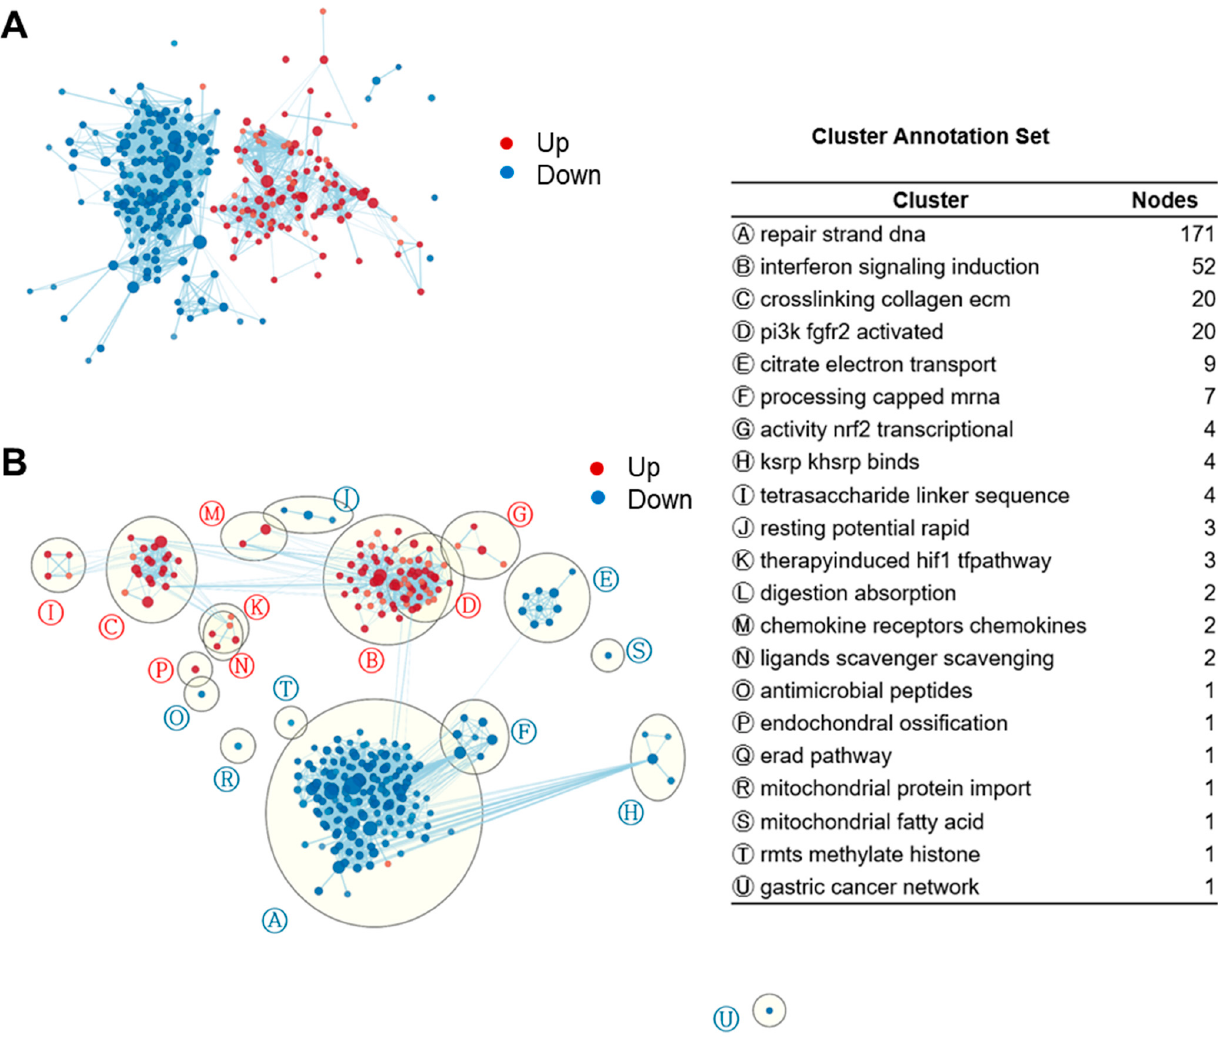
Figure 3. Enrichment maps of GSEA gene sets revealed strong induction of IFN signaling in fucoidan-treated BMDCs. ( A ) Unformatted GSEA gene sets enrichment map. Each node (circle) represents a distinct pathway, and edges (lines) represent the number of genes overlapping between two pathways, determined using the similarity coefficient. FDR < 0.08. Edge cutoff (Similarity) < 0.25. ( B ) AutoAnnotated enrichment map. Clusters were identified by the Cytoscape app and annotated with a representative label gleaned from the characteristics of the individual gene sets.